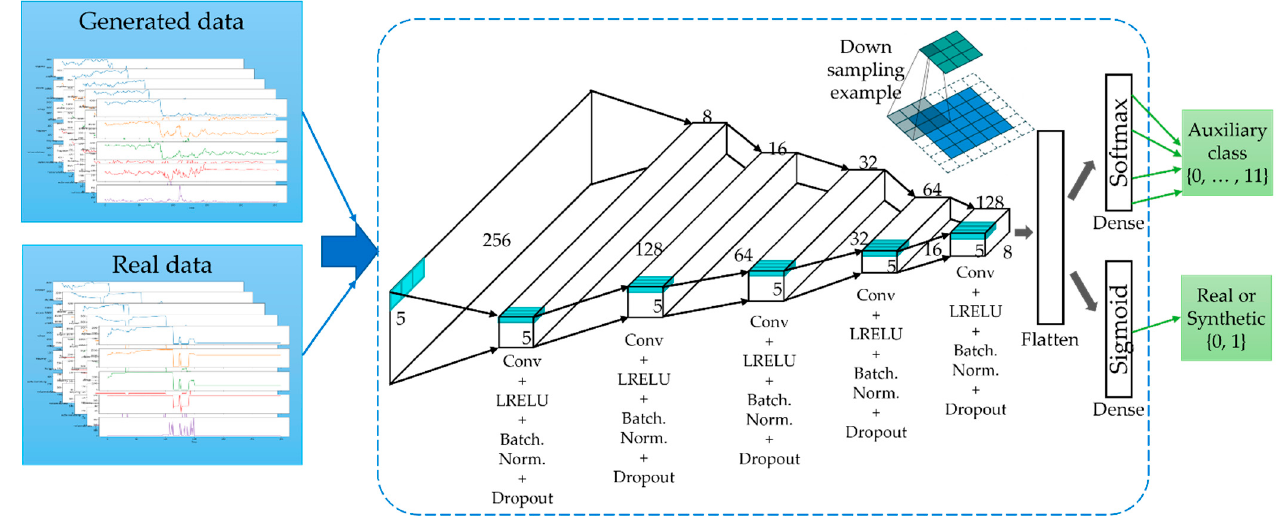
Figure A2. Implementation details of the discriminator model for the melting process.